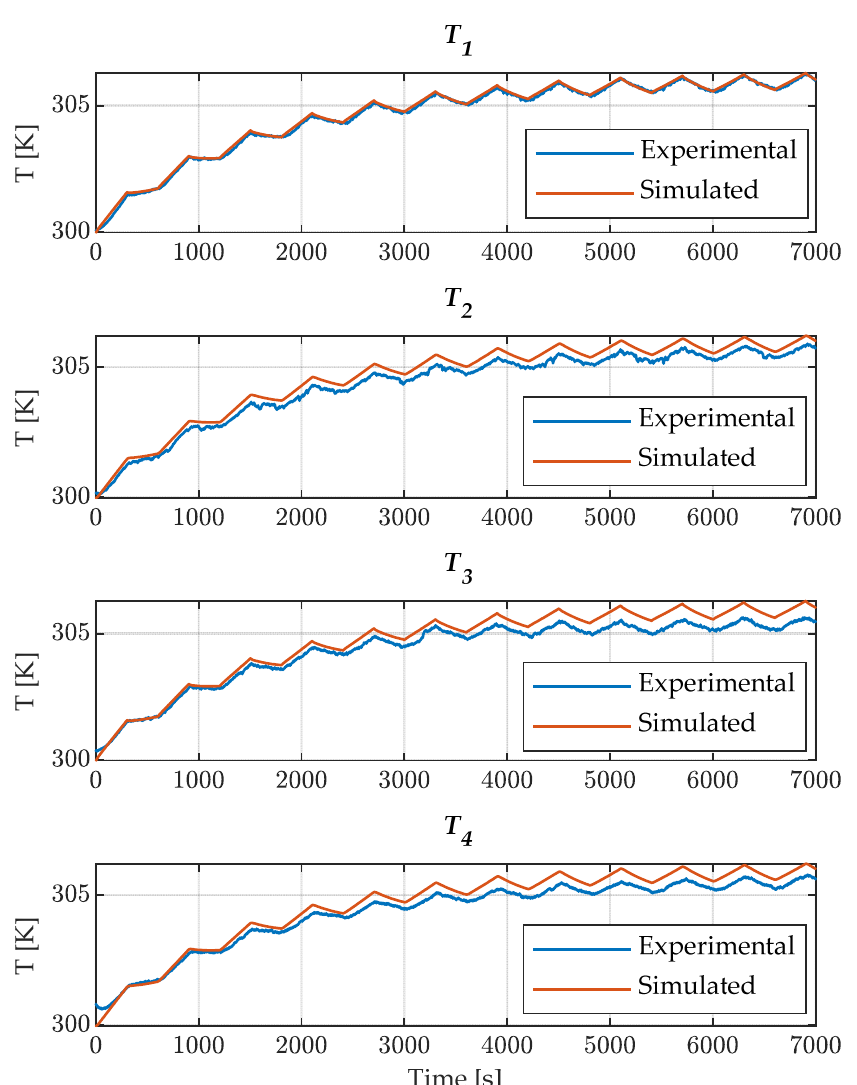
Figure 17. Thermocouples result for the three cells test at 30 A.